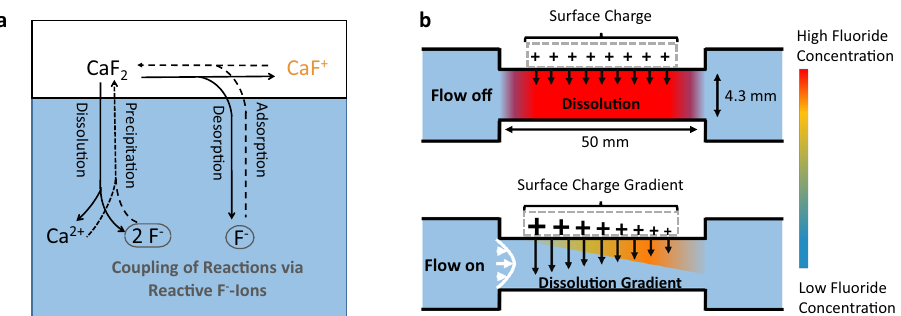
Fig. 4 Model of surface chemistry along the fl ow channel. a Illustration of the two interfacial reactions. CaF 2 is not only an adsorption – desorption site for fl uoride anions (Eq. (1)), which alters the surface charge, but also experiences charge-neutral dissolution – precipitation processes (Eq. (2)). The shared fl uoride anion couples the two reactions. b Illustration of the fl ow channel. Without fl ow (upper part), dissolution creates an enhanced F − concentration in steady-state, constant over the dissolving mineral surface, if the concentration reaches the saturation concentration. Dissolution rates and surface charge are also homogeneous along the mineral ’ s surface. However, upon fl ow (lower panel), the concentration is lowered everywhere in the channel, the more so closer to the inlet. This leads to an increase in the surface charge and higher net dissolution than in no- fl ow conditions, both becoming smaller at